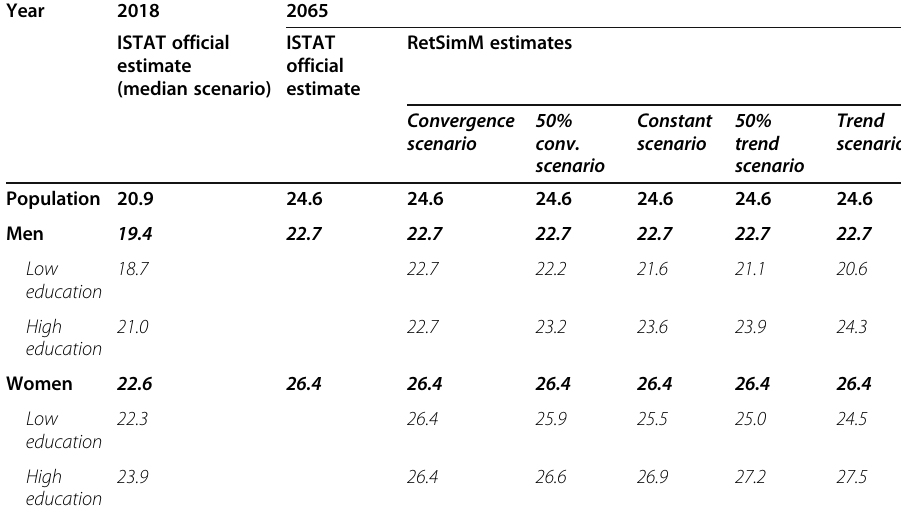
Table 1 Life expectancies at age 65 in 2018 and 2065, by sex and education level Year 2018 2065 ISTAT official estimate (median scenario)